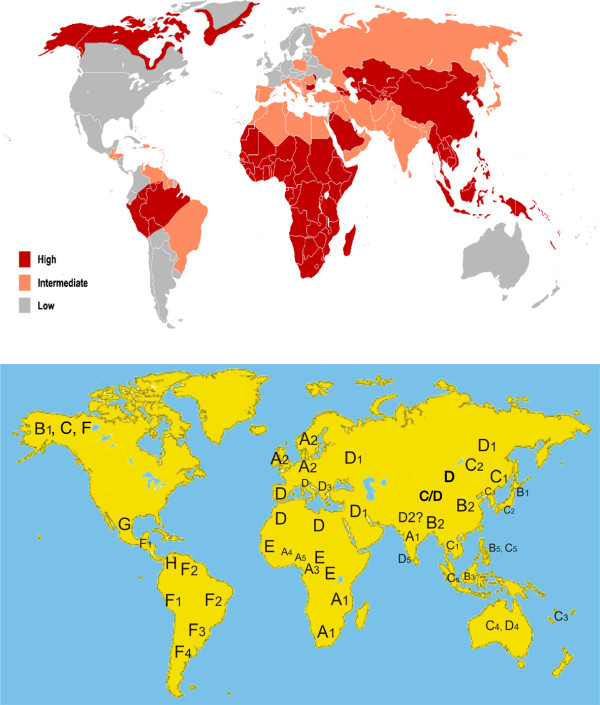
Prevalence (top) and genotype distribution (bottom) of HBV infections. Please note that HBV subgenotype A2, present in the most popular hepatitis B vaccines, is only prevalent in the low endemic regions of the Americas and Europe. This means that >99% of all HBV carriers have other HBV subgenotypes.